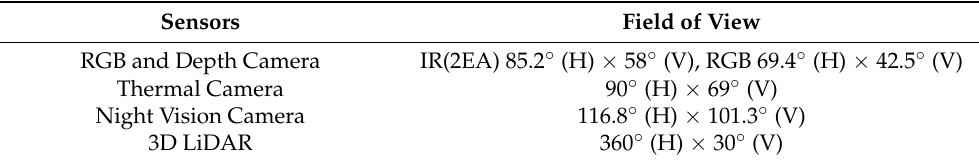
Figure 3. Arrangement of sensors. ( a ) Horizontal distance and ( b ) vertical distance. Table 1. Field of view for multi-modal sensors. Sensors